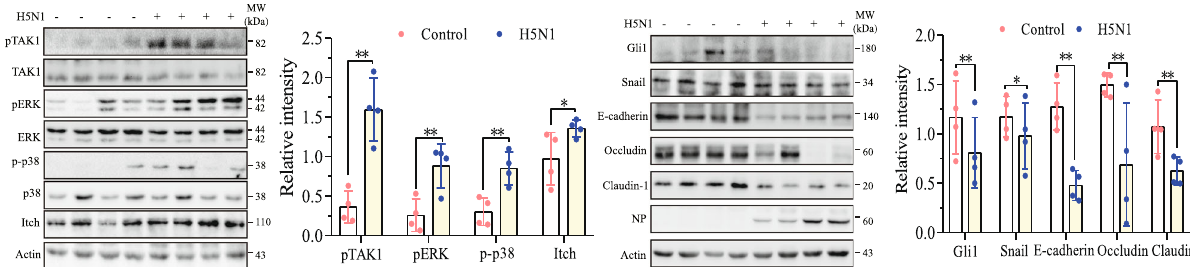
Fig. 8 IAV infection activates the TAK1-Itch axis and decreases the levels of epithelial junction proteins in vivo. C57BL/6 mice were left uninfected or infected with H5N1 viruses (1000 pfu/mouse, 4 mice/group). Forty-eight hours post-infection, mice were sacri fi ced. The lung tissue was collected and analyzed for TAK1, p38, and ERK phosphorylation and the levels of Itch and the epithelial junction proteins by Western blot with the indicated antibody. The density of the bands from four mice per group was analyzed by using NIH Image-J software and normalized by the arbitrary units of β -actin. Data represent the mean ± SD of three experiments. *p < 0.05, **p